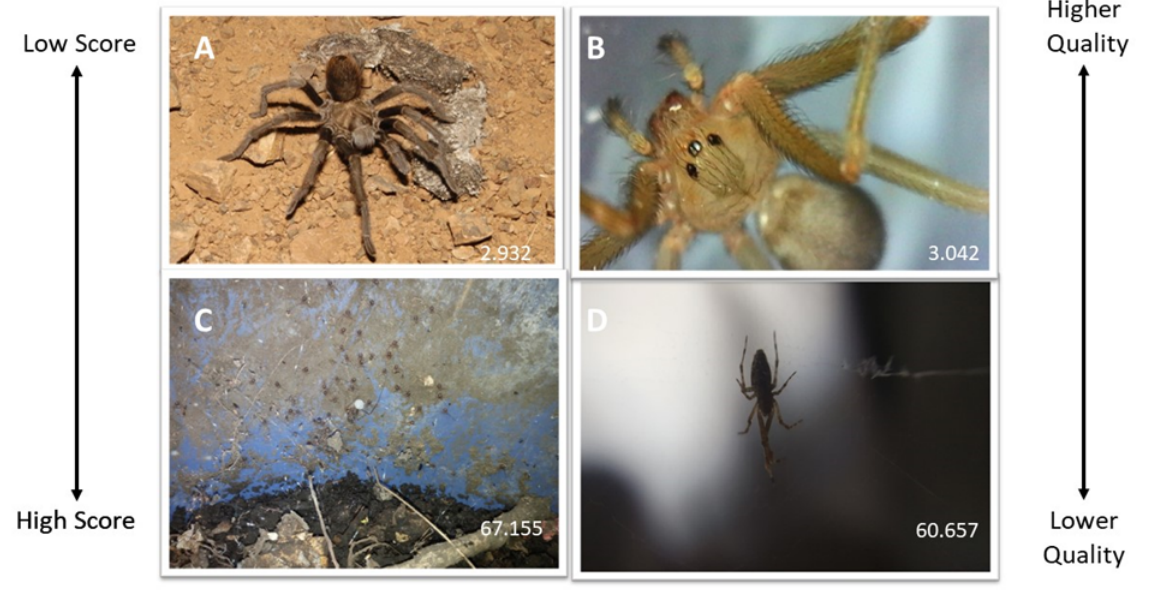
Figure 5. BRISQUE Image Quality. BRISQUE evaluates images without the need for a reference photo.